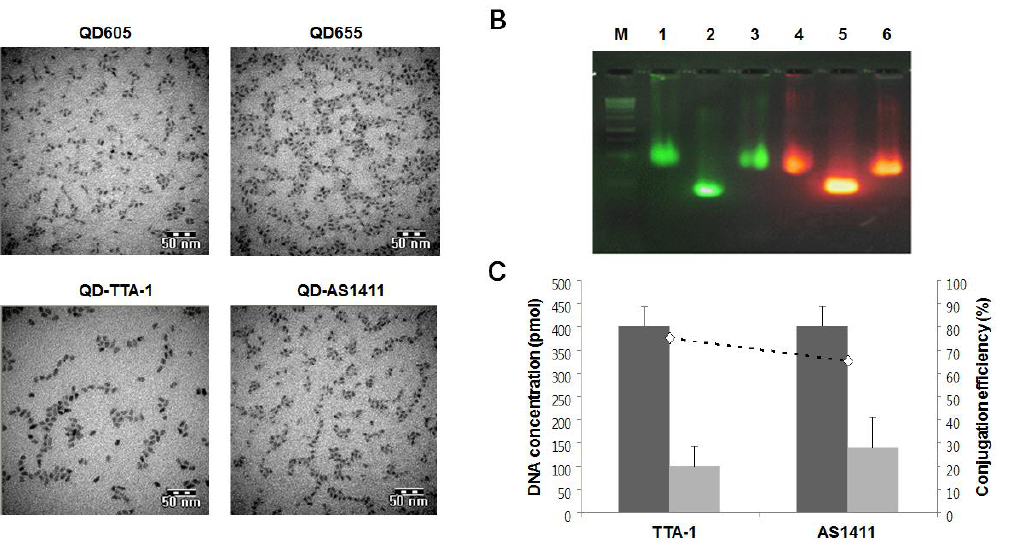
Figure 1. Characterization of quantum dot (QD)-aptamer conjugates. ( A ) TEM images of QDs and QD-aptamer conjugates; ( B ) Gel electrophoresis of QD-TTA-1 and QD-AS1411. QD-TTA-1 (lane 1), QD605 (lane 2), QD-TTA-1mt (lane 3), QD-AS1411 (lane 4), QD655 (lane 5), and QD-AS1411mt (lane 6). Size marker is indicated by “M”. Data evaluated by UV excitation (235/345 nm); ( C ) Conjugation efficiency of QD-TTA-1 and QD-AS1411. Dark gray bars indicate QD-aptamer conjugates and white gray bars indicate unconjugated QDs. Data are displayed as means ± standard deviations of triplicate